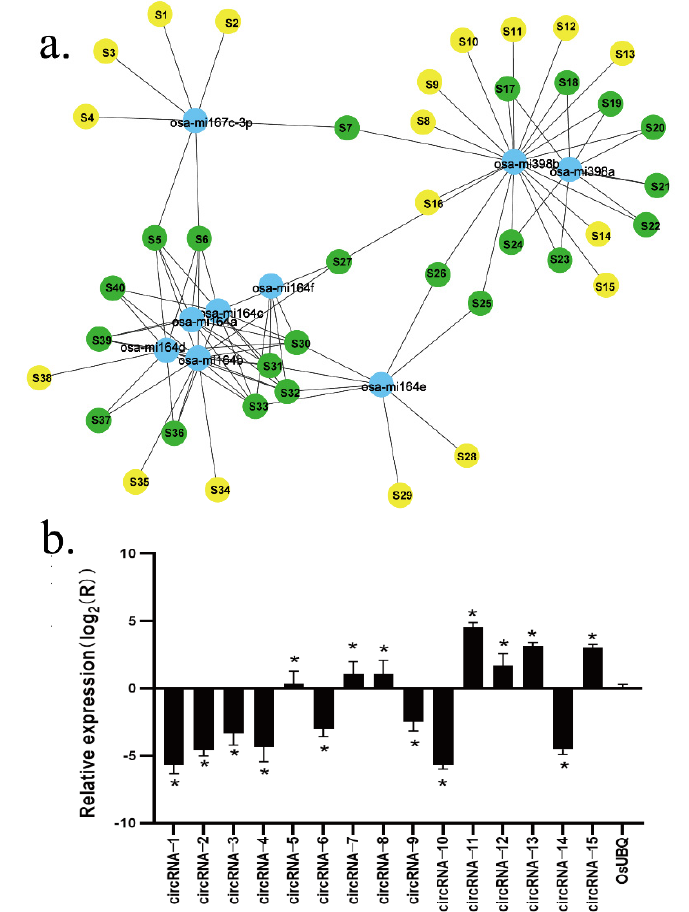
Figure 3. ( a ) Networked view of the differentially expressed circRNAs targeting miRNAs. Blue represents miRNA, green represents circRNA that targets more than two miRNAs, and yellow represents less than two miRNAs. ( b ) Validation of the differentially expressed circRNAs by real-time PCR assay and Sanger sequencing. See Table 1 for the circRNA names. Means of samples denoted with the “*” are significantly different at p < 0.05 according to the t-test compared to the control after 5 d. The ID represented by S1–S40 is in the Supplementary Table S7.